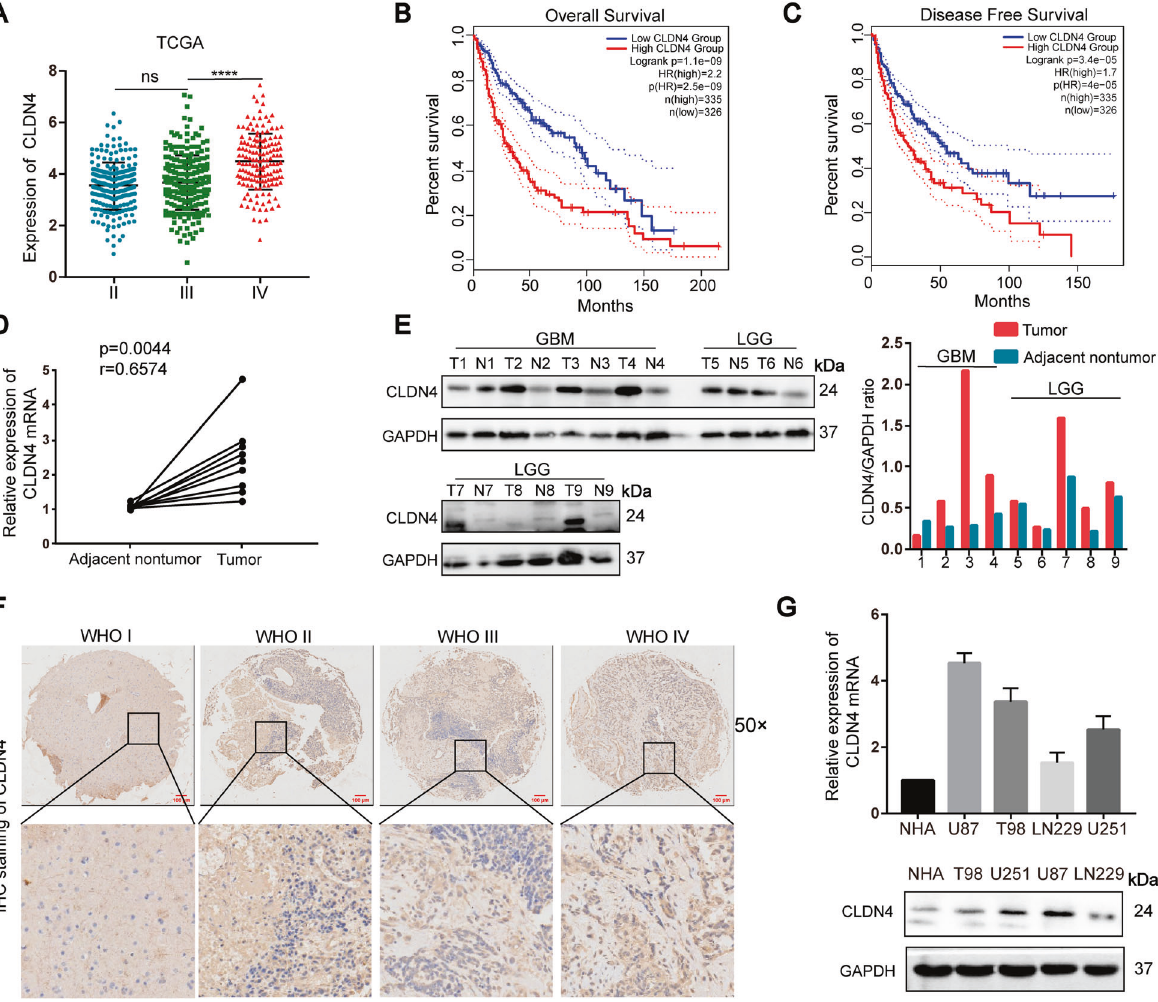
Fig. 1 CLDN4 is upregulated in glioma cells and tissues. A CLDN4 expression in glioma tissues from the TCGA database (**** p < 0.0001, Student ’ s t -test). B , C The correlation between CLDN4 expression and overall survival (OS) and disease-free survival (DFS) in glioma patients. D RT-PCR and Western blotting (N adjacent normal tissue, T tumor tissue) were used to determine CLDN4 protein levels in nine paired GBM samples. E , F The IHC scores of CLDN4 in patients with different grades of glioma were analyzed, and representative images are shown (50×). G The expression of CLDN4 in GBM and NHA cell lines as determined by RT-qPCR and western blotting. (* p < 0.05, ** p <